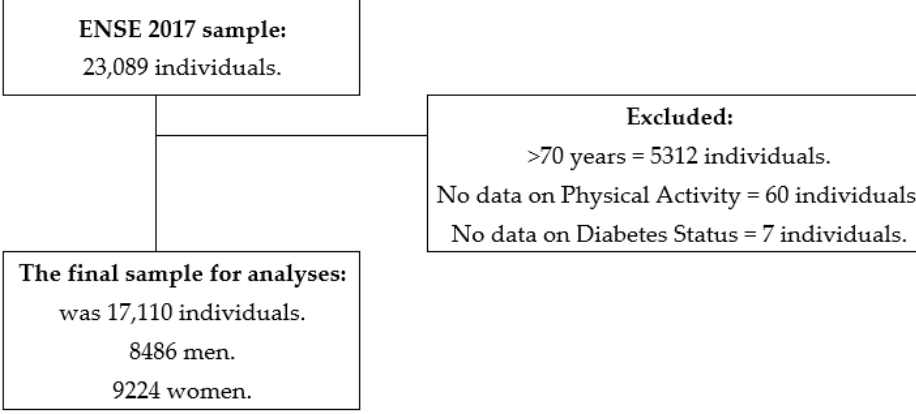
Figure 1. Chart outlining the study sample ’ s eligibility